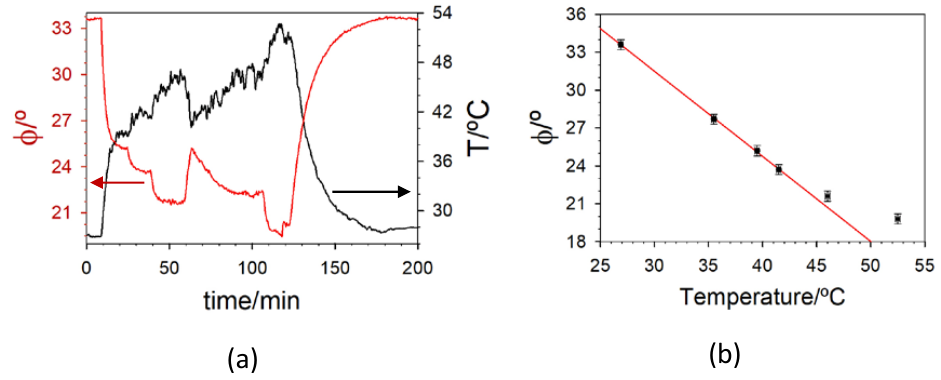
Figure 7. ( a ) Example of the fiberoptic luminescence-based temperature sensor response (red line). The temperature was varied with a heating plate (IKA RCT basic) and monitored with a commercially available thermistor (LM335, Texas Instrument, black line); ( b ) Phase-shift response with temperature. The red line is the linear fit of the experimental data between 26.9 and 41.5 °C (parameters of the best fit φ /° = A + b T /°C: A = (51.7 ± 0.3)°; b = ( − 0.674 ± 0.009)°(°C) − 1 ; r ² = 0.9996). The response is linear between 27 and 43 °C, a suitable range for monitoring cell cultures [47].